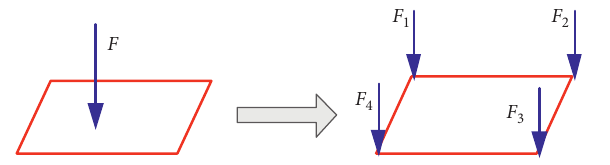
Figure 2: Contact point load distribution.